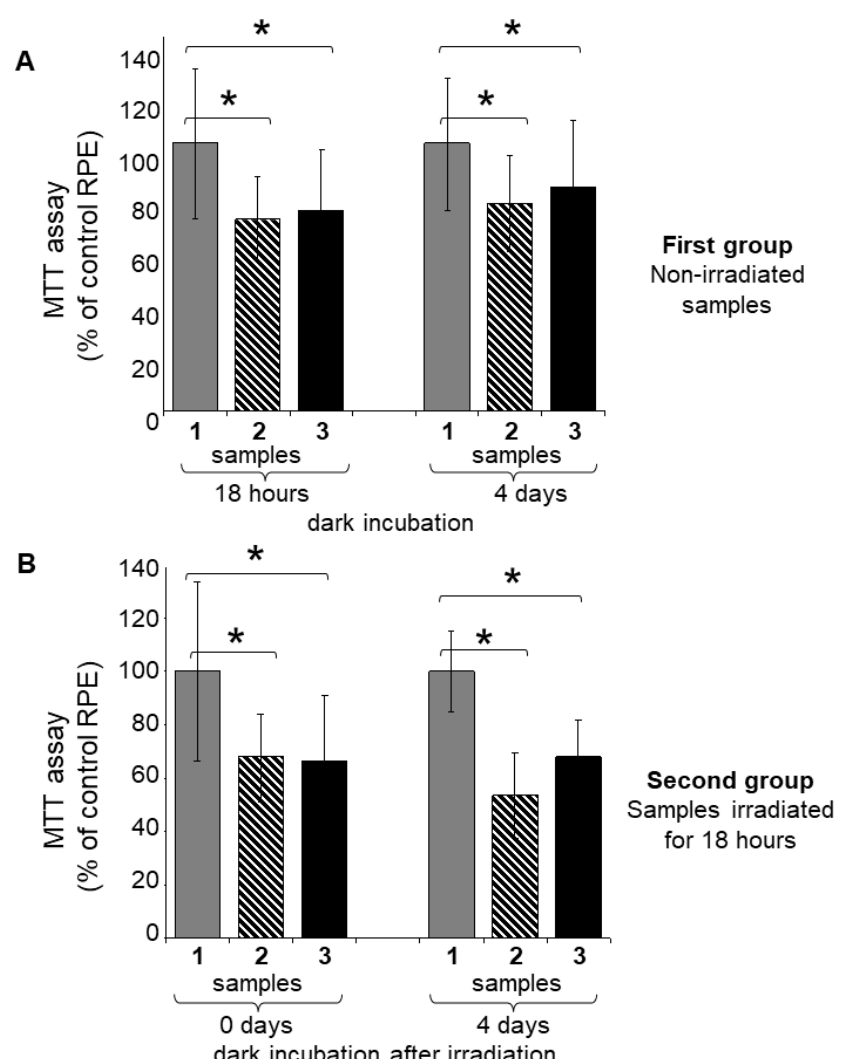
Figure 5. MTT cell viability assay. Samples: 1—original RPE cell culture without lipofuscin granules (LGs); 2—LG-fed RPE cells; 3—LG*-fed RPE cells. ( A ) All samples (first group) were maintained in